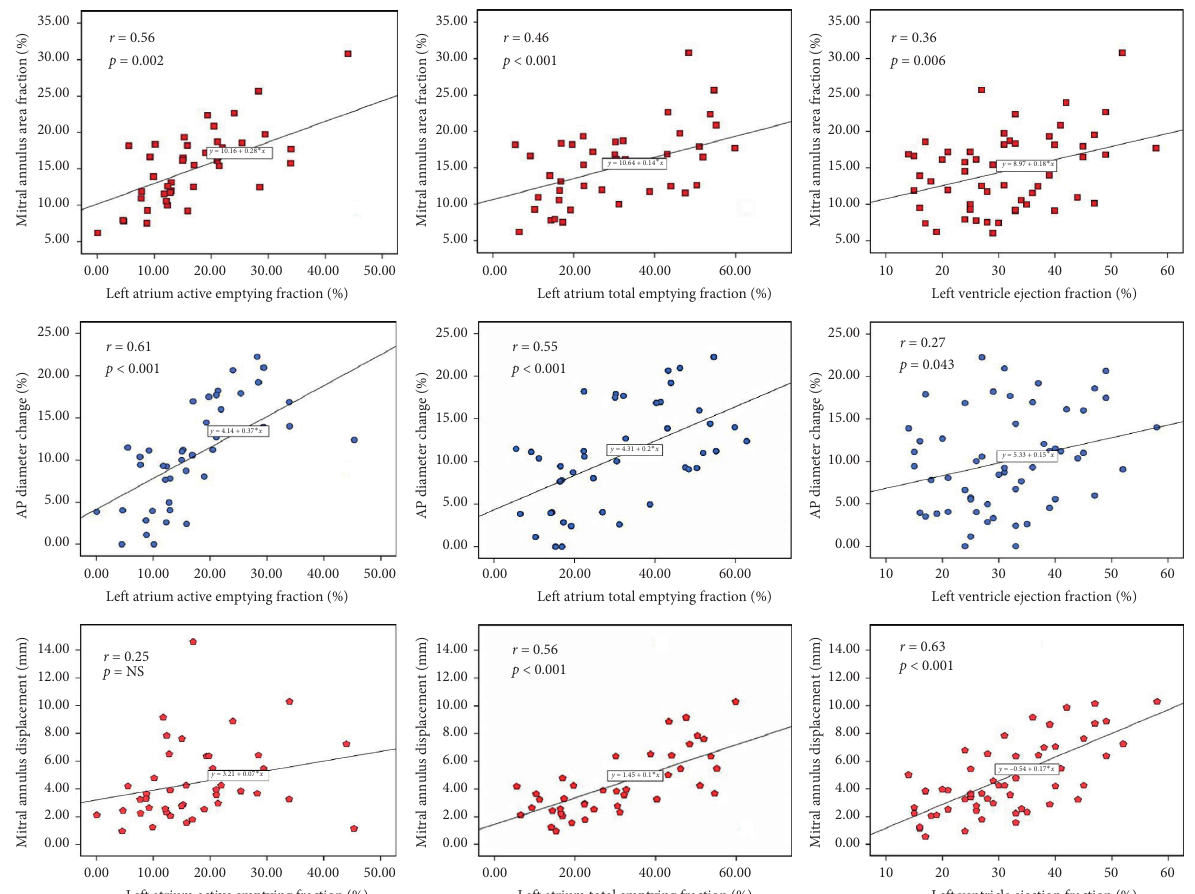
Figure 5: Relation between mitral annular functions and left atrial and left ventricular functions in patients with functional mitral re- gurgitation. AP: anteroposterior